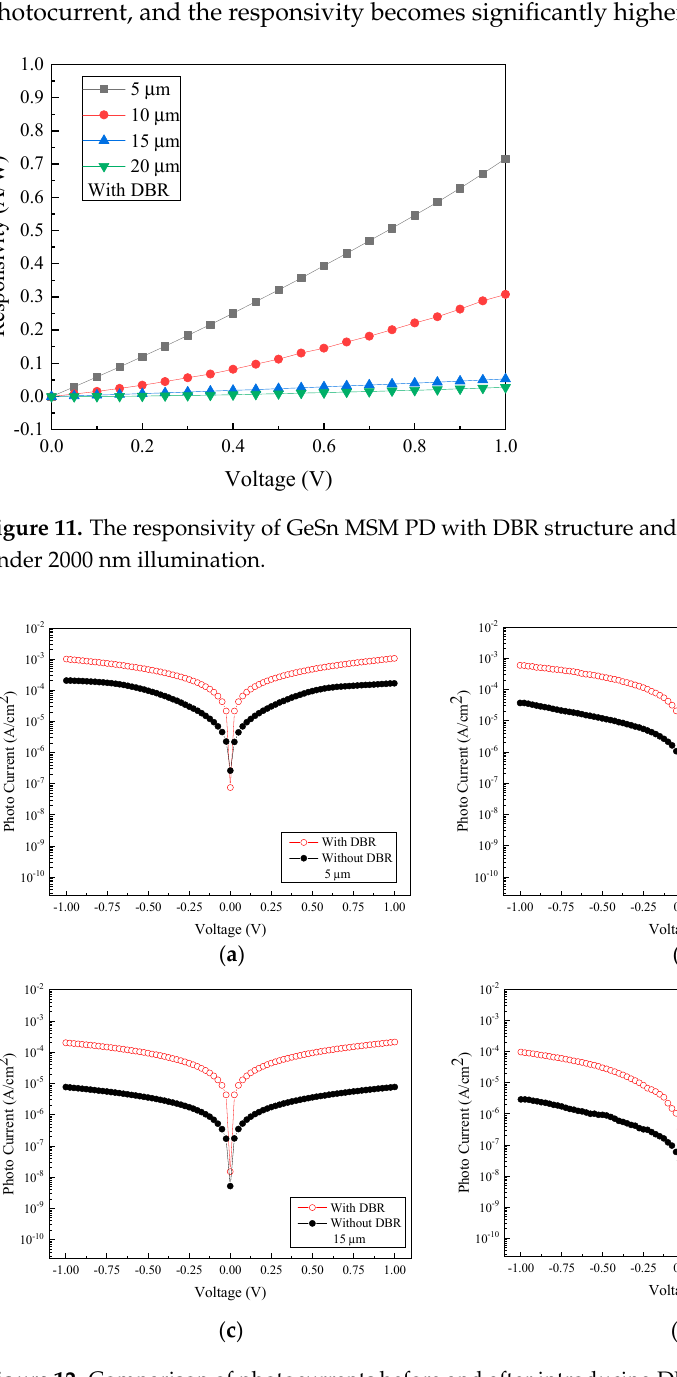
Figure 12. Comparison of photocurrents before and after introducing DBR to the PDs of four different electrode sizes: ( a ) 5 µm, ( b ) 10 µm, ( c ) 15 µm, and ( d ) 20 µm.